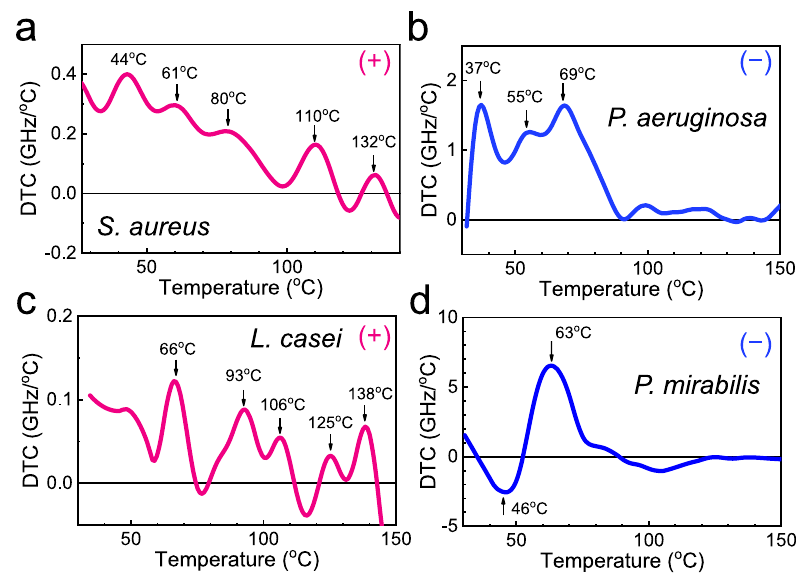
Fig. 3 Differential thermal curve results for four bacterial species. DTCs for a S. aureus , b P. aeruginosa , c L. casei , and d P. mirabilis . Gram-negative bacteria ( P. aeruginosa and P. mirabilis ) do not exhibit noticeable peak corresponding to the cell wall destruction (i.e., at T > 100 °C). Positive ( + ) and negative ( – ) signs denote the Gram-positive and Gram-negative bacteria,